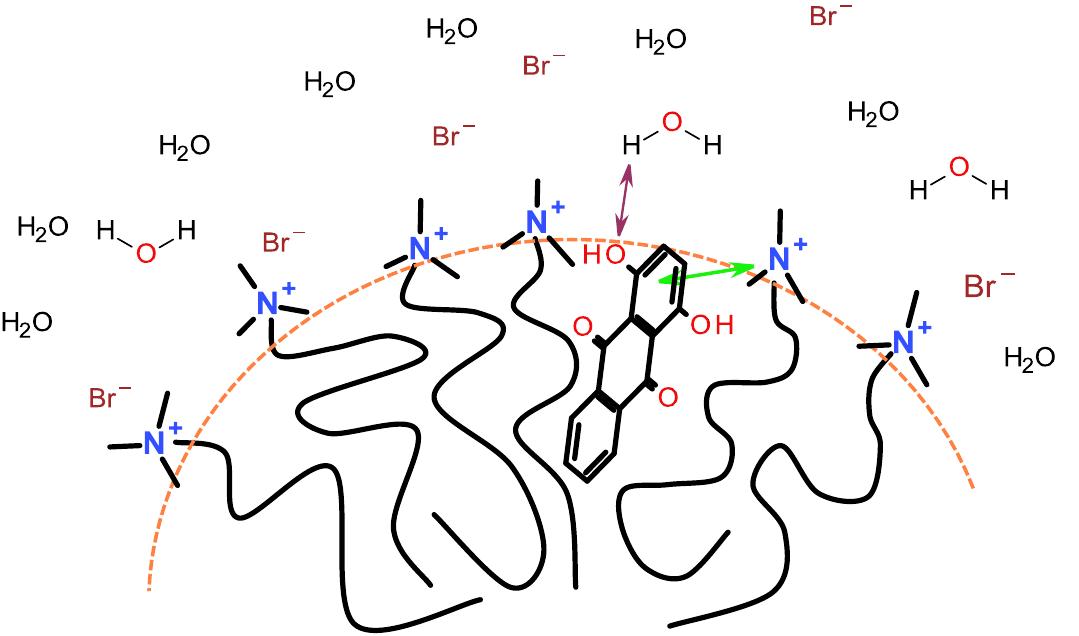
Figure 14. Assumed location of the dye C.I. Solvent Orange 86 (Quinizarin) in a micelle of a cationic